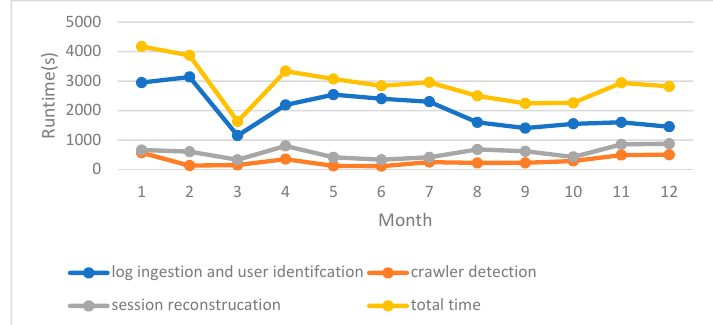
Figure 12. The processing time of logs in 2014 with and without framework. Appl. Sci. 2019 , 9 , x FOR PEER REVIEW